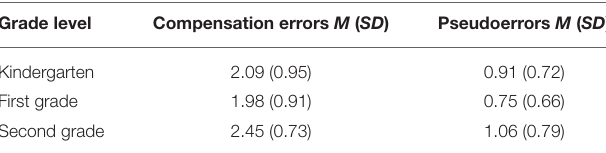
TABLE 4 | Means and standard deviations ( SD ) of correct responses in the detection